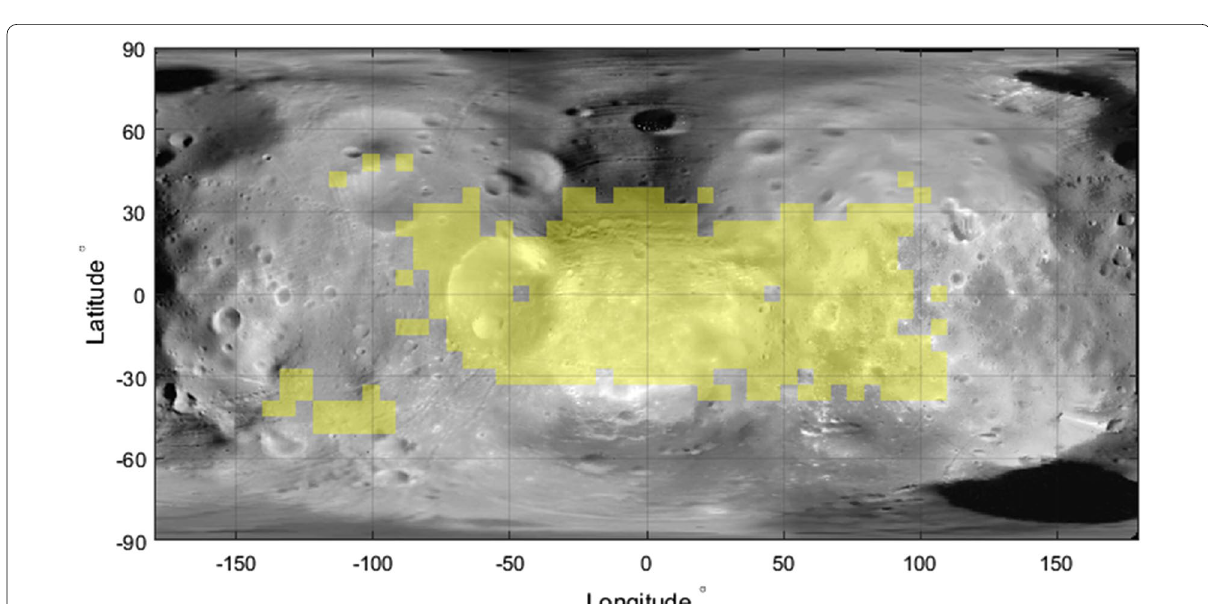
Fig. 13 Locations on Phobos meeting 8 science and operations requirements projected onto global HRSC SRC mosaic. Note this figure is phase‑shifted by 180° in longitude compared to previous figures of Phobos, with the Mars‑facing at 0° longitude centered in the x‑axis to highlight the continuous region in which most requirements are